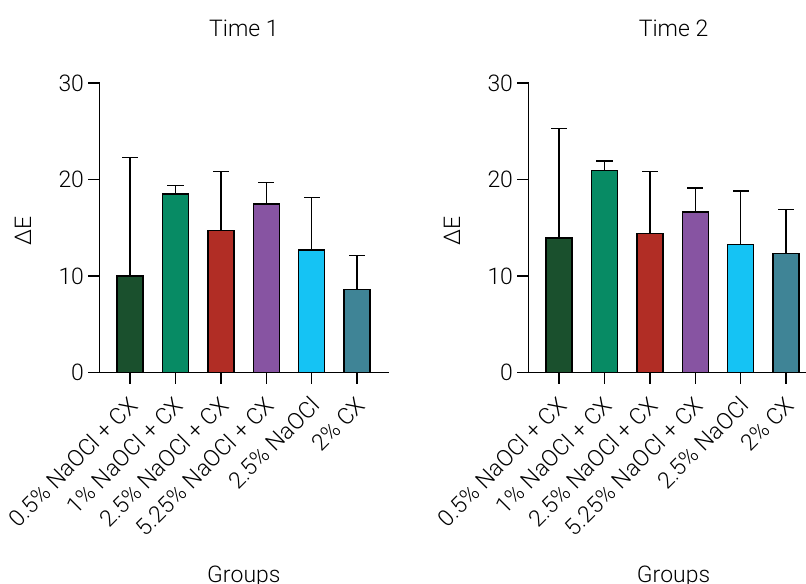
Figure 3. Mean and standard deviation of variation of the color (DE) between groups in the moments immediately after irrigation (T1) and 24 hours after the irrigation protocol